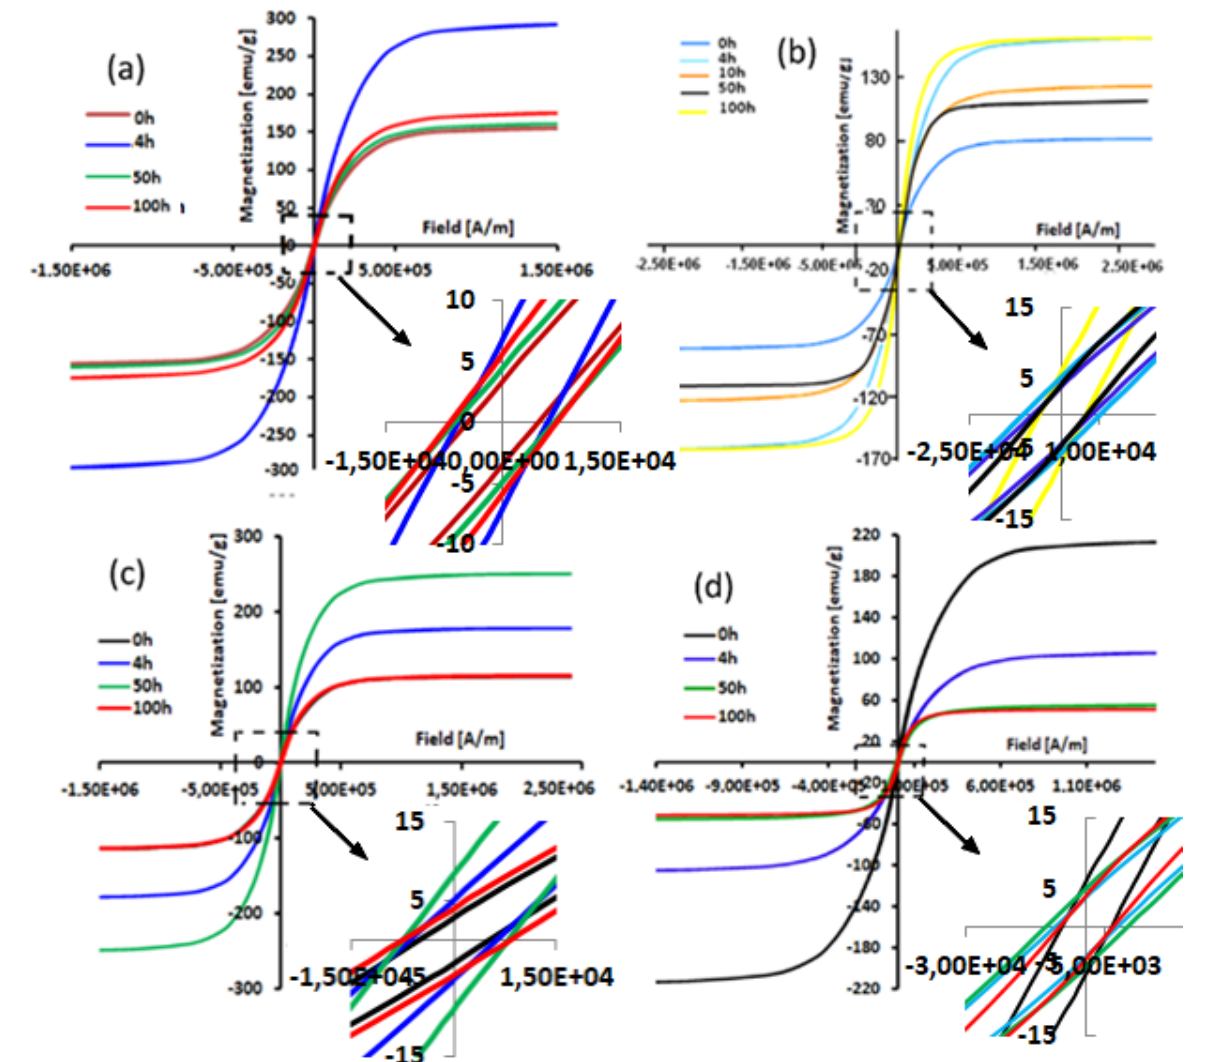
Figure 4. Typical hysteresis cycles (at 300 K) of the MA Fe 60-x Co 25 Ni 15 Si x alloys: x = 5 ( a ), x = 10 ( b ), x = 20 ( c ), and x = 30 ( d ) at.% for selected milling times. (Units: 1 emu/g = 1 Am 2 Kg). Notation: E+06 corresponds to × 10 6 , symbol—correspond to minus. Table 1. Refined average crystallite sizes, <D> ( ± 5 nm), lattice strains, ε ( ± 0.02%), and